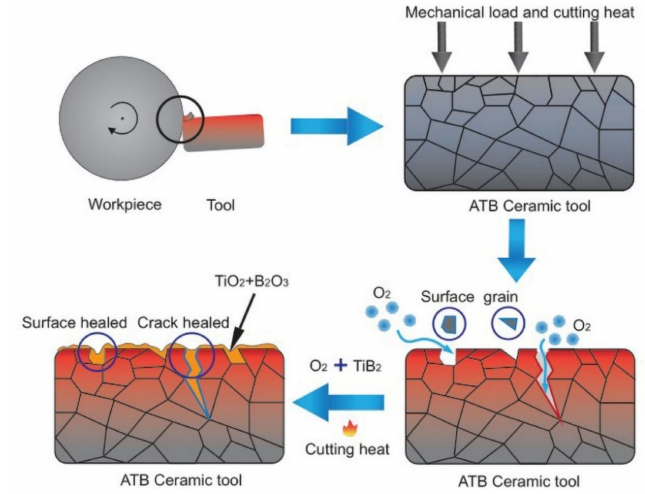
Figure 12. Repair mechanism of ATB tool in cutting